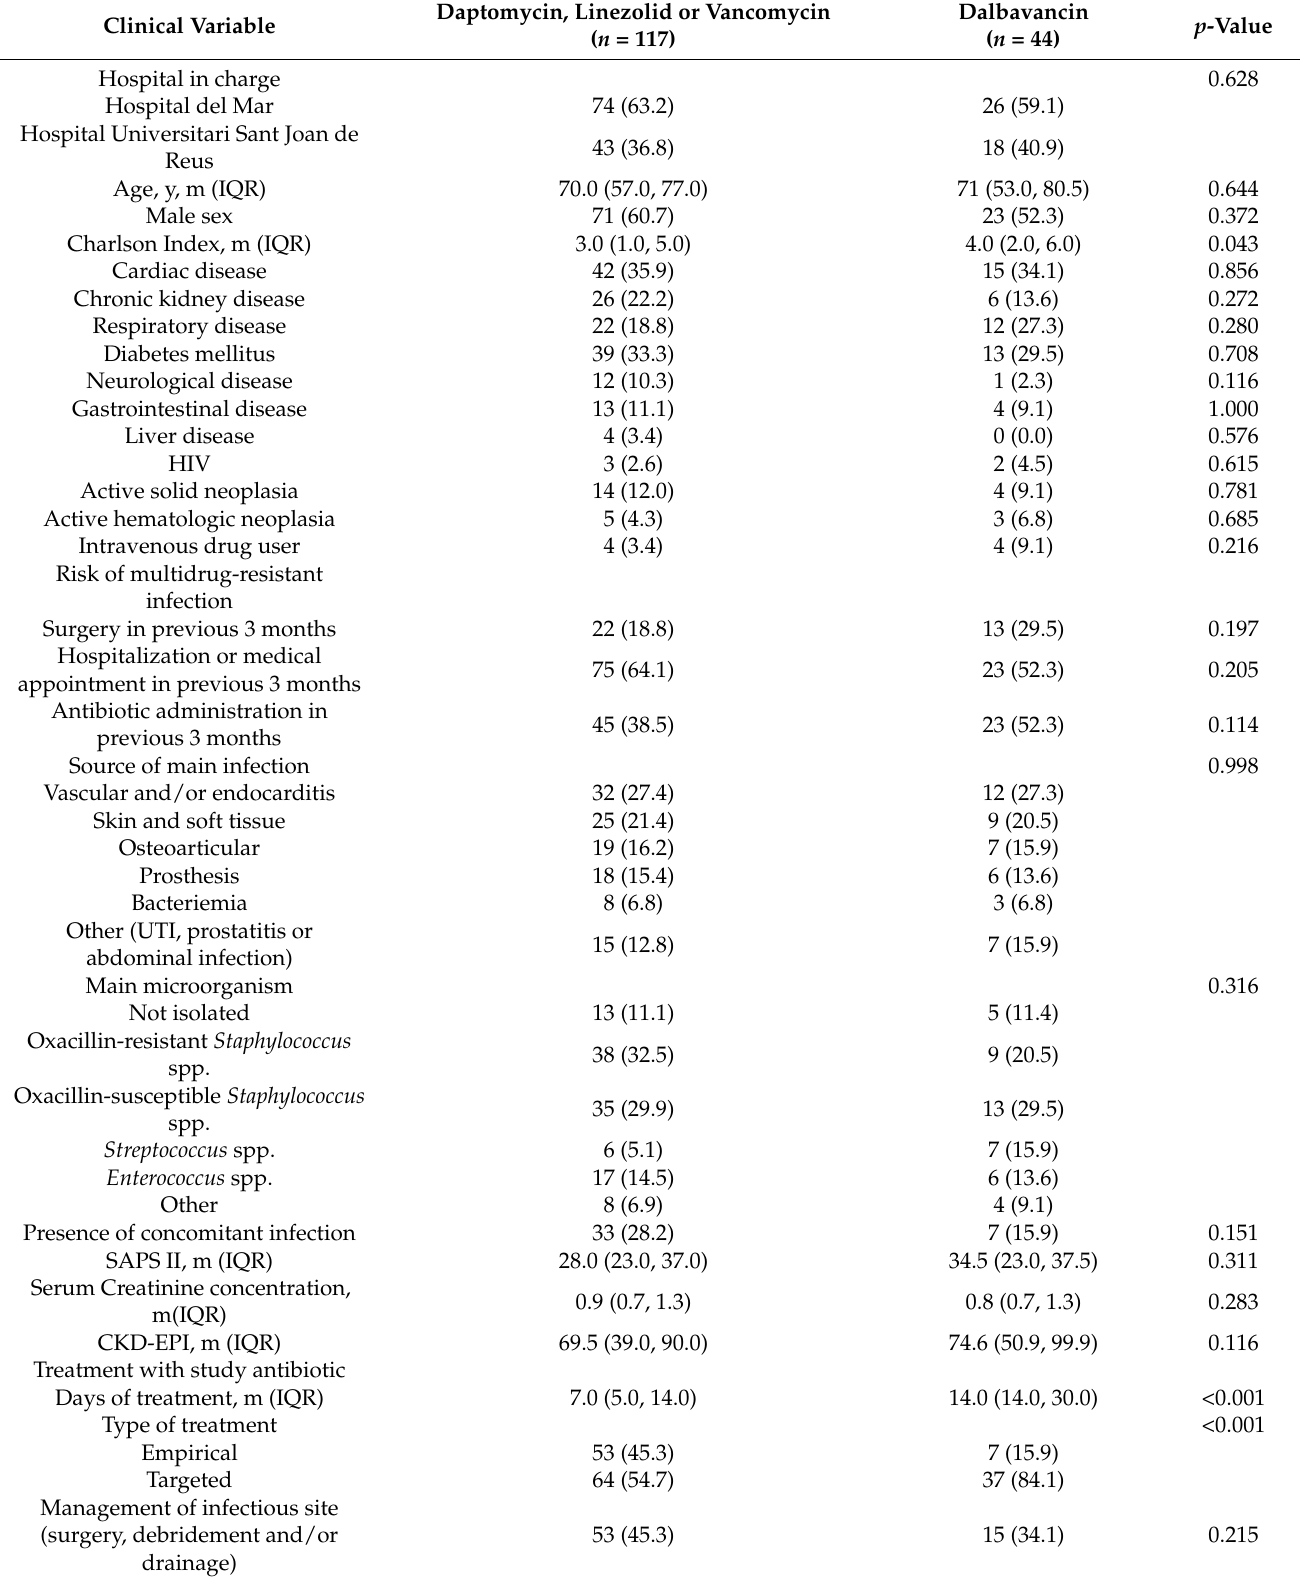
Table 1. Baseline characteristics for patients treated with dalbavancin (cases) and those treated with other conventional antimicrobial therapies (daptomycin, linezolid, and vancomycin) (controls). Clinical